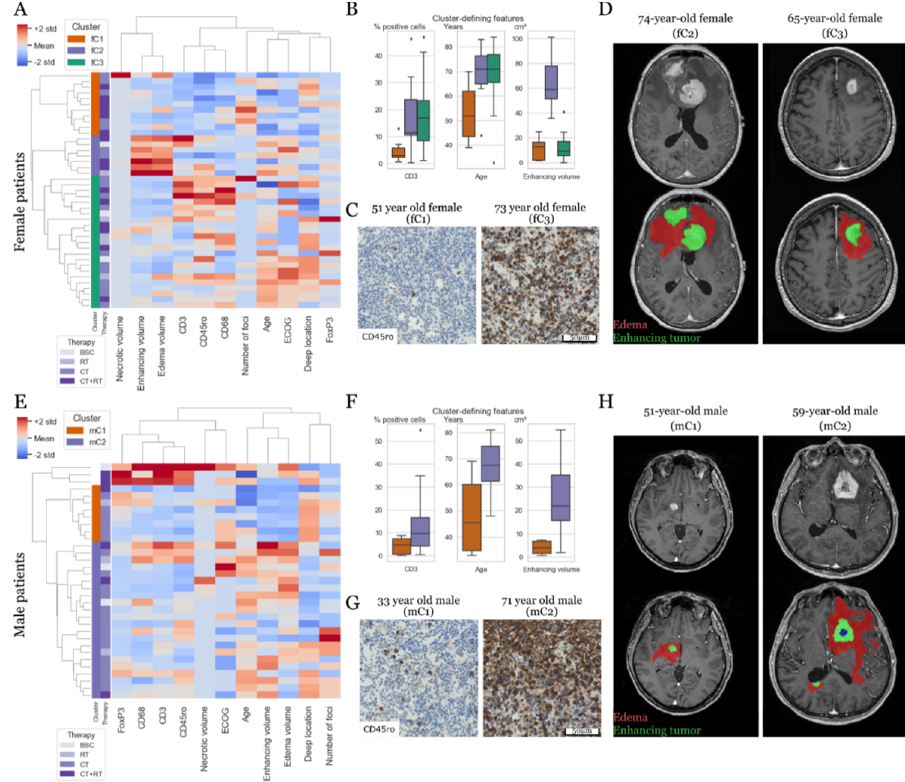
Figure 2. Cluster analysis (Euclidean distance, Ward-linked) based on numerical and ordinal variables. ( A – D ) Female patients. ( E – H ) Male patients. ( A ) Cluster analysis of the female dataset results in three clusters that significantly differ in the combination of features, three of which are depicted in ( B ), such as immune response (CD3+ TILs), age, and contrast enhancement (all p < 0.01, ANOVA). ( C ) Comparison of the CD45ro+ immune response of two representative female patients. ( D ) Comparison of the MR imaging features of two representative female patients. ( E ) Cluster analysis of male patients yields two main clusters. ( F ) Examples of cluster-defining features include immune response (CD3+ TILs), age, and contrast enhancement (all p < 0.01, ANOVA). ( G ) Comparison of the CD45ro + immune response of two representative male patients. ( H ) Comparison of the MR imaging features of two representative male